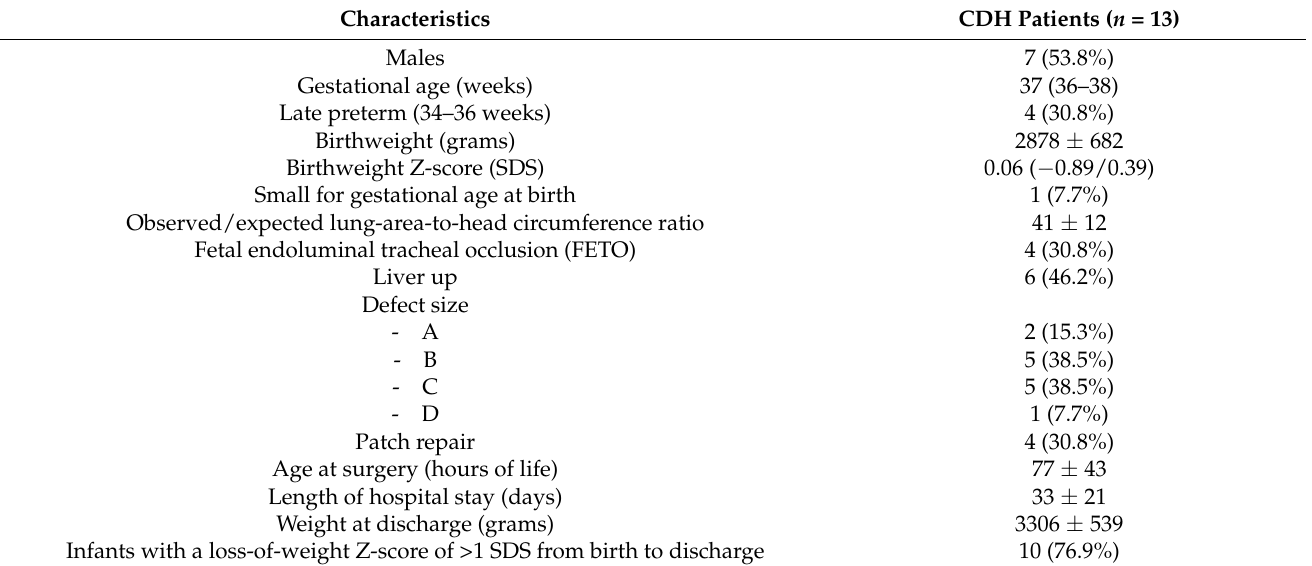
Table 1. Characteristics of CDH infants included in the study. Results are expressed as numbers (percentages) and means ( ± standard deviation) or medians